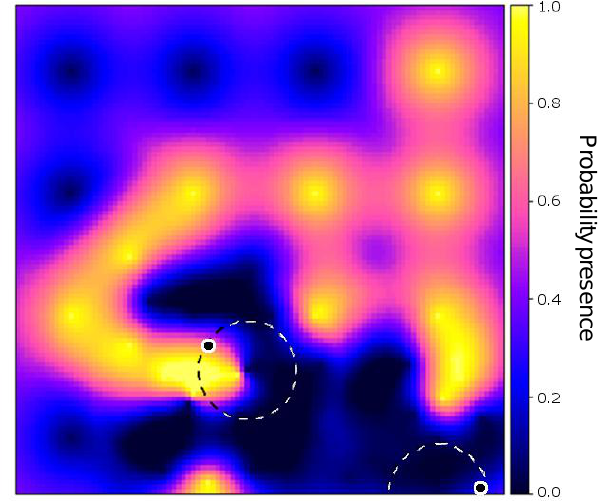
Figure 5. Probability of presence after 15 time steps in which two simultaneous sensor measurements were added (scenario 2). Each sensor only scanned a limited neighbourhood around their current position (indicated by the dashed circle) for the optimal solution, which caused them to get trapped. The concentric black-white dots (eyes) indicate the newly selected